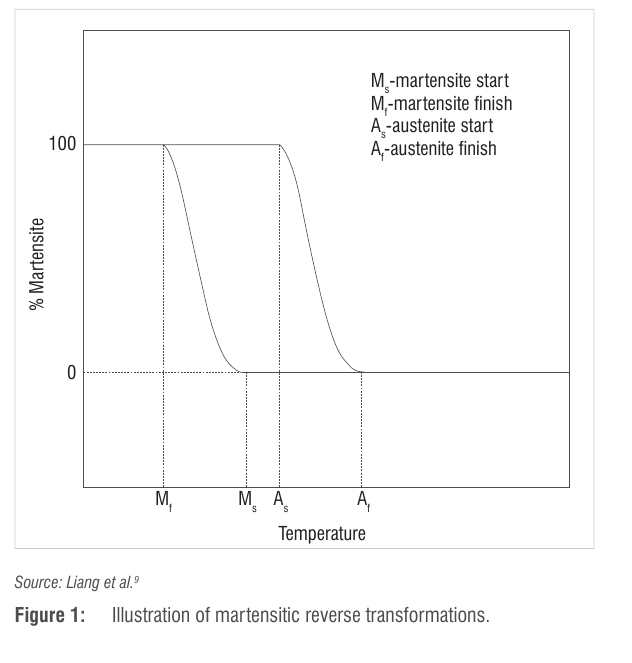
Figure 1: Illustration of martensitic reverse transformations.